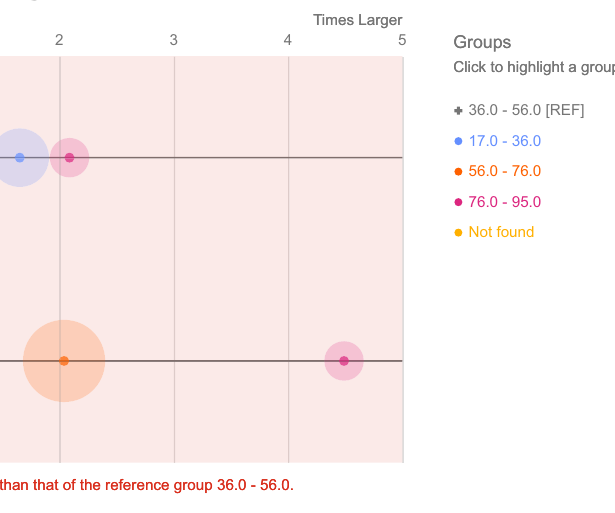
Figure 9. Aequitas results on FPR and FDR the attribute